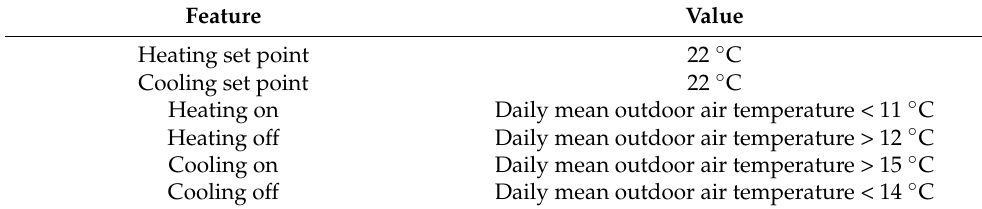
Table 4. System operation characteristics in the SolAce